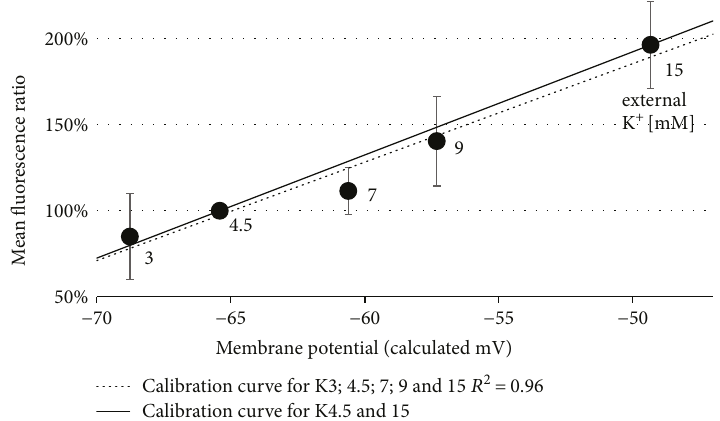
Figure 1: Calibration curves for alterations in the mean fl uorescence depending on the calculated membrane potential. Shown here are the linear regression curves for two (solid line) or fi ve di ff erent potassium concentrations (dotted line). 4.5 mM potassium was considered the physiological extracellular concentration and set to 100%. The method allows the detection of small alterations in membrane potential with an increase in the fl uorescence of 6.0% (solid line) or 5.7% (dotted line) per mV increase in membrane potential. N = 5 per